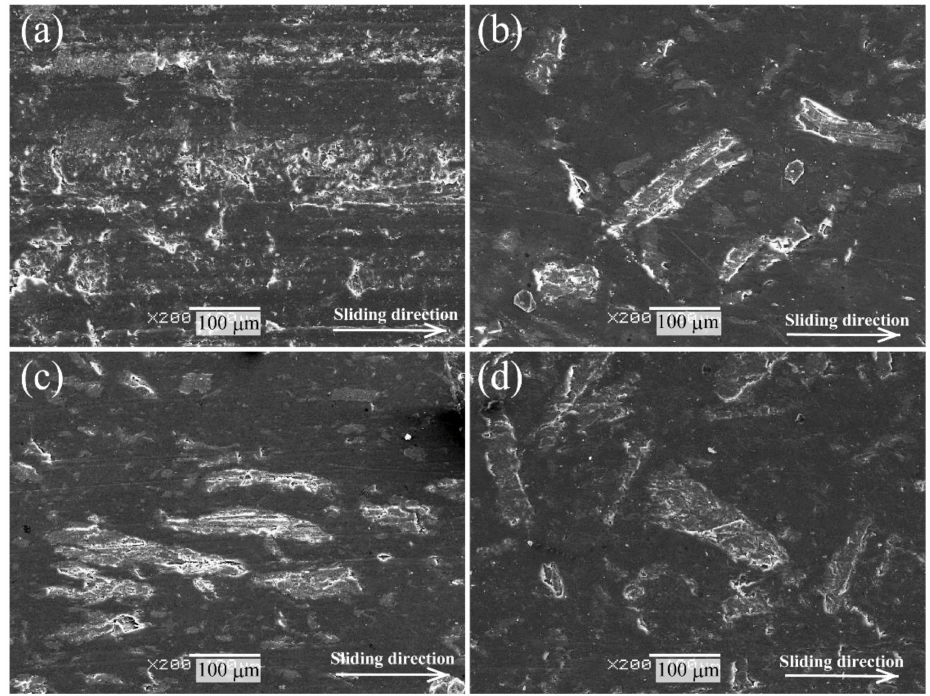
Figure 12. SEM photographs of the worn surface of polymer composite specimens after the sliding wear test against carbon steel S45C of various surface-treated HF/PA1010 biomass composites: ( a ) HF_NaClO 2 , ( b ) HF_NaClO 2 + EP, ( c ) HF_NaClO 2 + A-1160, and ( d ) HF_NaClO 2 + A-1160 + EP ( ×